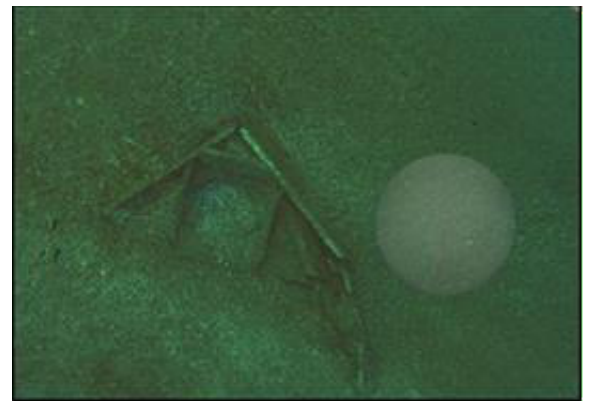
Figure 10. The produced model